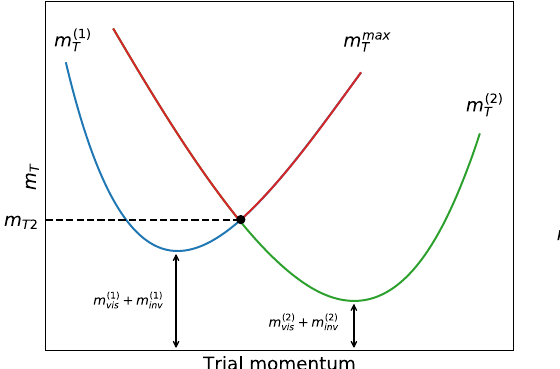
m ( 1 , 2 ) , represent the masses of the visible and invisible final state parti- inv ( 1 , 2 ) cles. In the case studied in this paper, where the masses of the final state as a function T particles are negligible in comparison to the mass of the decaying heavy ( 1 ) ( 2 ) particle, the m and m have their minima values approximately at T T zero and therefore only the balanced solution topology is ( 1 , 2 ) and vis